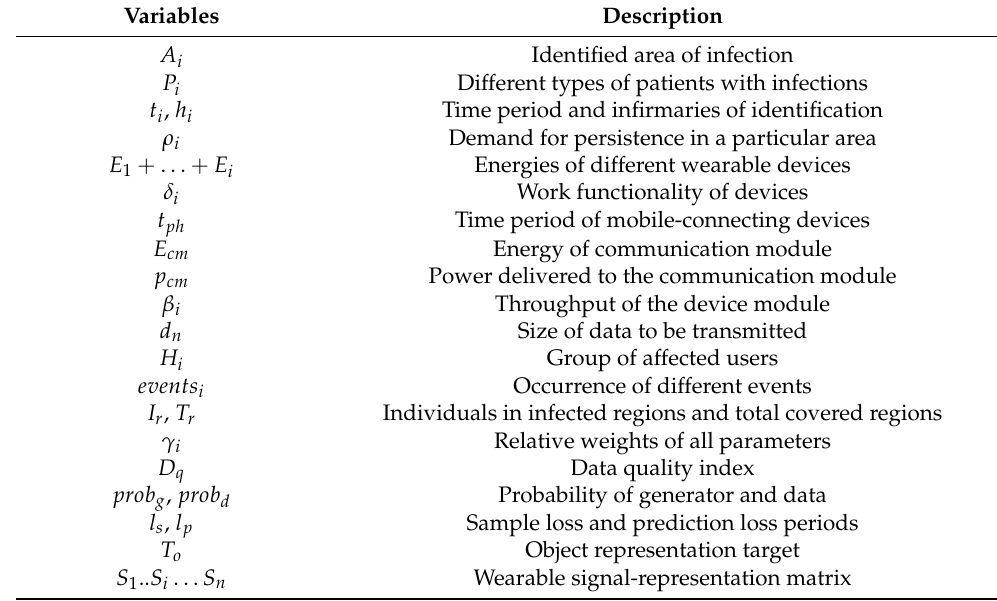
Table 2. Mathematical